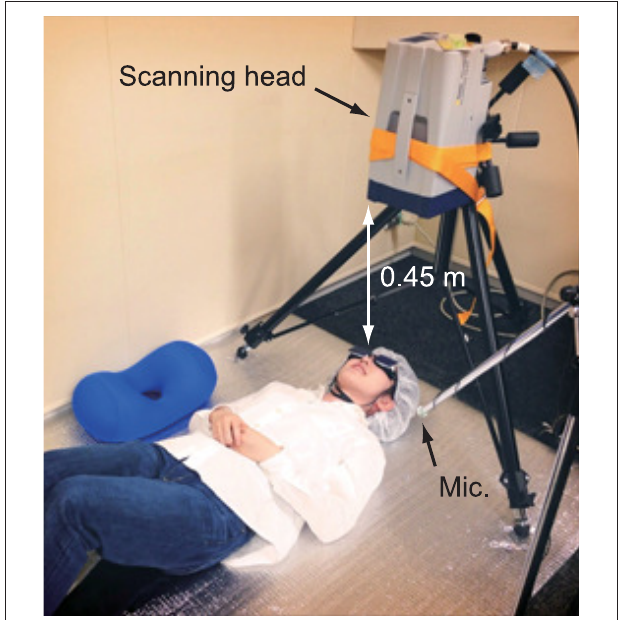
FIGURE 2 | Configuration of measurement instruments and participant.